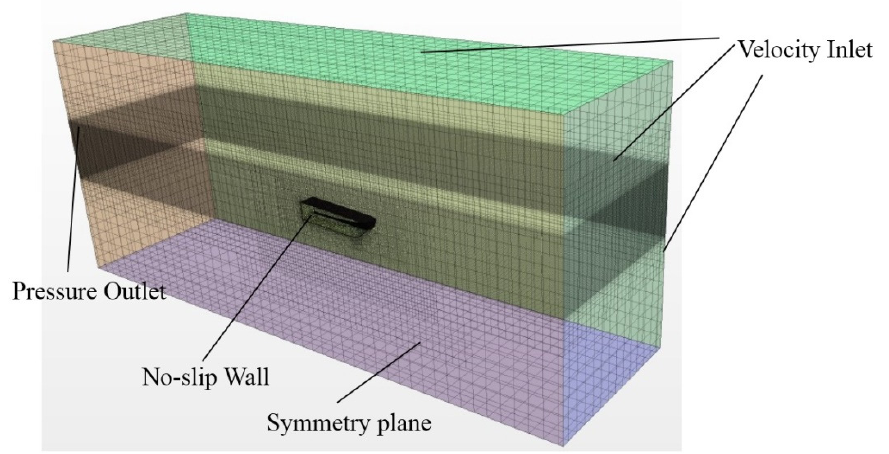
Figure 6. Boundary conditions. Figure 6. Boundary